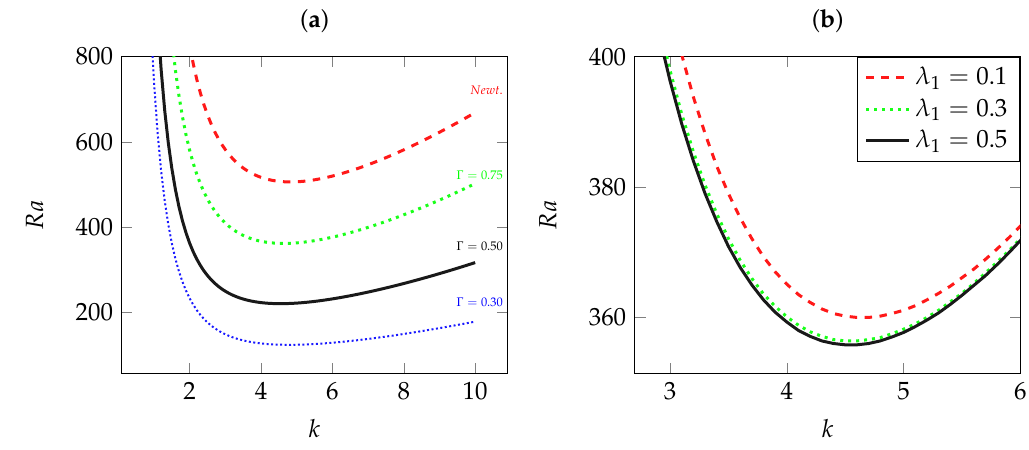
Figure 7. Critical Rayleigh number for the destabilization of fully-developed flow against the wave number k with l = 0 for Newtonian fluids (Newt) and for viscoelastic solutions with: ( a ) λ 1 = 0.1 and Γ = 0.75;0.5;0.3; ( b ) Γ = 0.75 and λ 1 = 0.1;0.3;0.5.